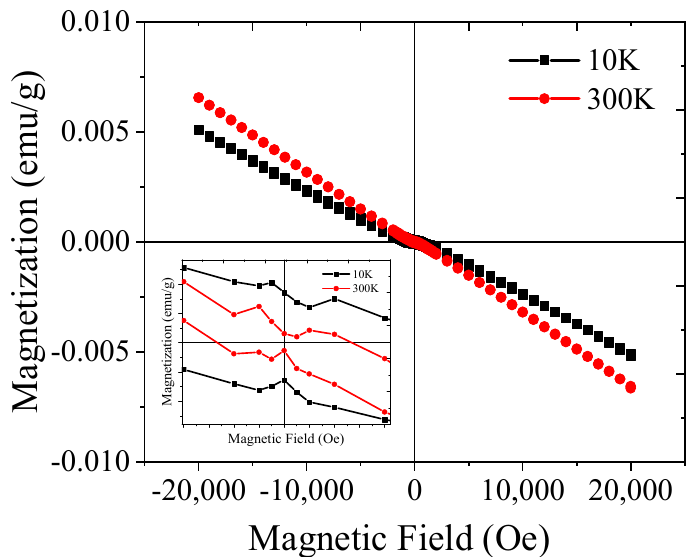
Figure 9. M-H curves at 10 and 300 K .